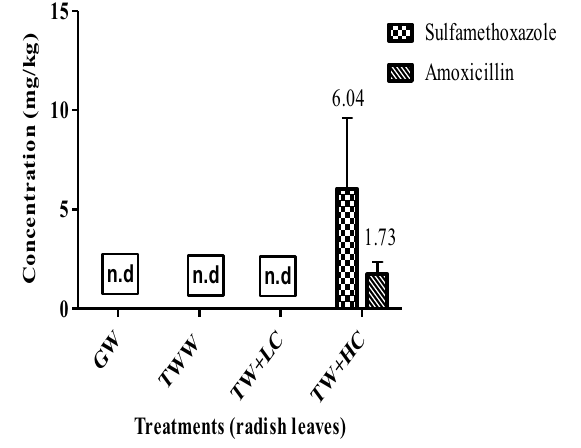
Table 1 Summary of the detected concentrations of selected pharmaceuticals in radish leaves and roots